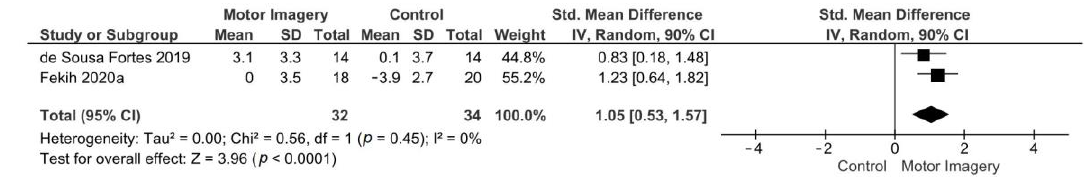
Figure 3. Risk of bias rating within domains Domain 1 to Domain 5 as percentage of all studies. Legend: D1 = Randomization process, D2 = deviations from intended interventions, D3 = missing outcome data, D4 = measurement of the outcome, D5 = selection of the reported results.